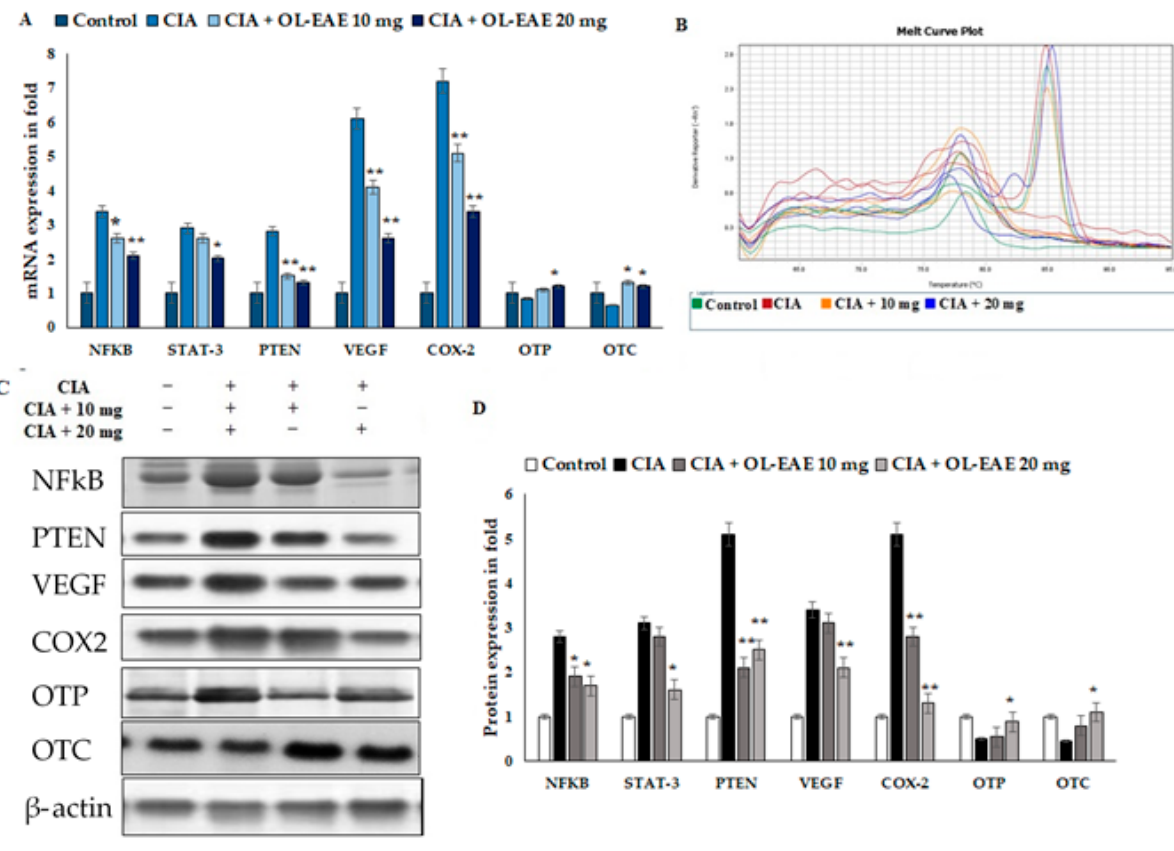
Figure 6. Effects of OL -EAE extract on NF- κ B, STAT-3, PTEN, VEGF, COX-2, OTP, and OTC signaling. Metabolic markers were quantified using real-time PCR and Western blot methods. ( A ) The inhibitory effects of OL -EAE extract after 28 days of treatment with 10 and 20 mg extract concentrations suppressed the inflammatory mediators in both mRNA and protein levels. Quantification was determined via RNA extraction, cDNA preparation, and the quantification of specific genes using real-time PCR. The gene expression levels were quantified using the ∆∆ cT method. ( B ) Melting curve of PCR reaction determined the calibrated gene expression of this experiments ( C , D ) The cell lysate was collected and subjected to Western blot analysis. The primary antibody of each target was from the monoclonal antibodies from abbexa, abcam, and biorybt. The density of each band was analyzed using ImageJ v1.6. Each value is expressed in triplicate as the mean ± SD; * p < 0.05 and ** p < 0.001 when comparing the CIA disease group with the CIA/ OL -EAE-treated group ( n = 6).